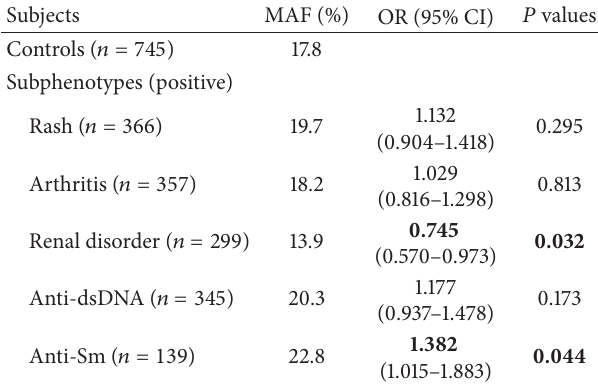
Table 5: Association analyses between rs2295415 and subpheno- types in